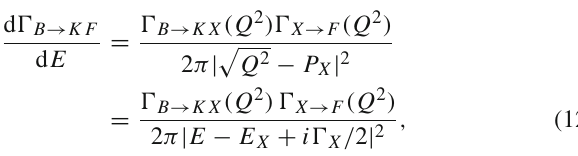
Fig. 2 Skeleton Feynman diagram for the p ¯ p → F (cid:7) F scattering through the X ( 3872